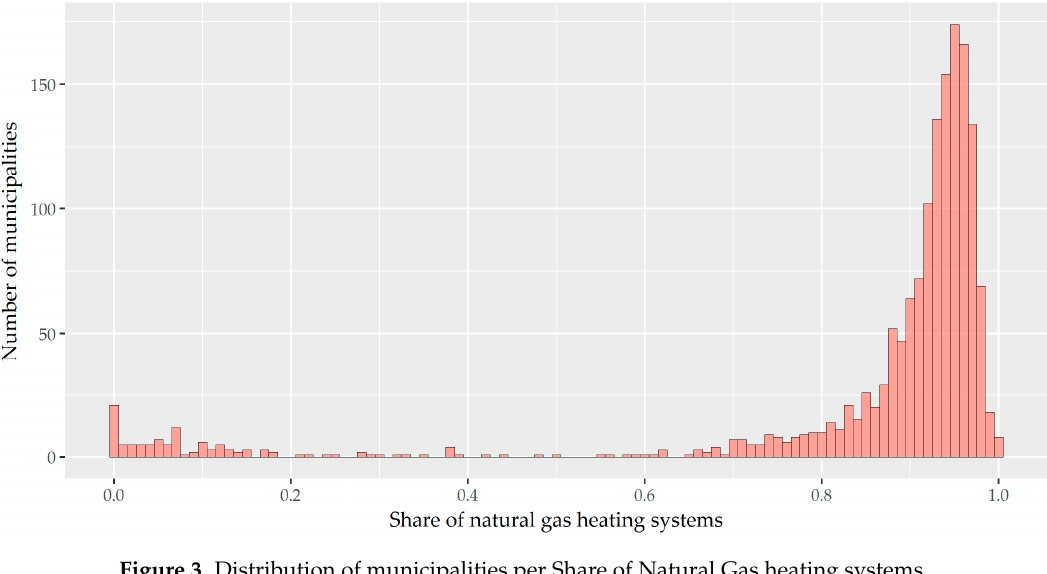
Figure 3. Distribution of municipalities per Share of Natural Gas heating systems.